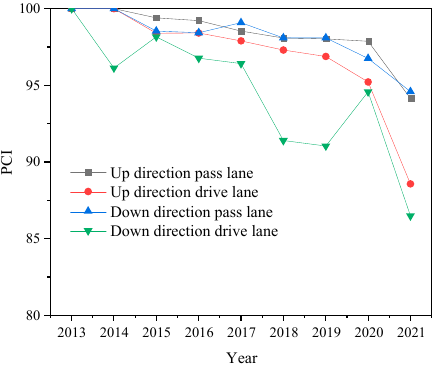
Figure 7. PCI of XHMB pavement.